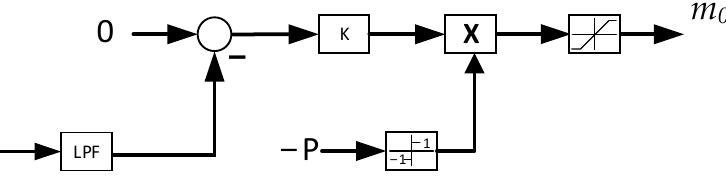
Figure 10. DC voltage equalizer controller.